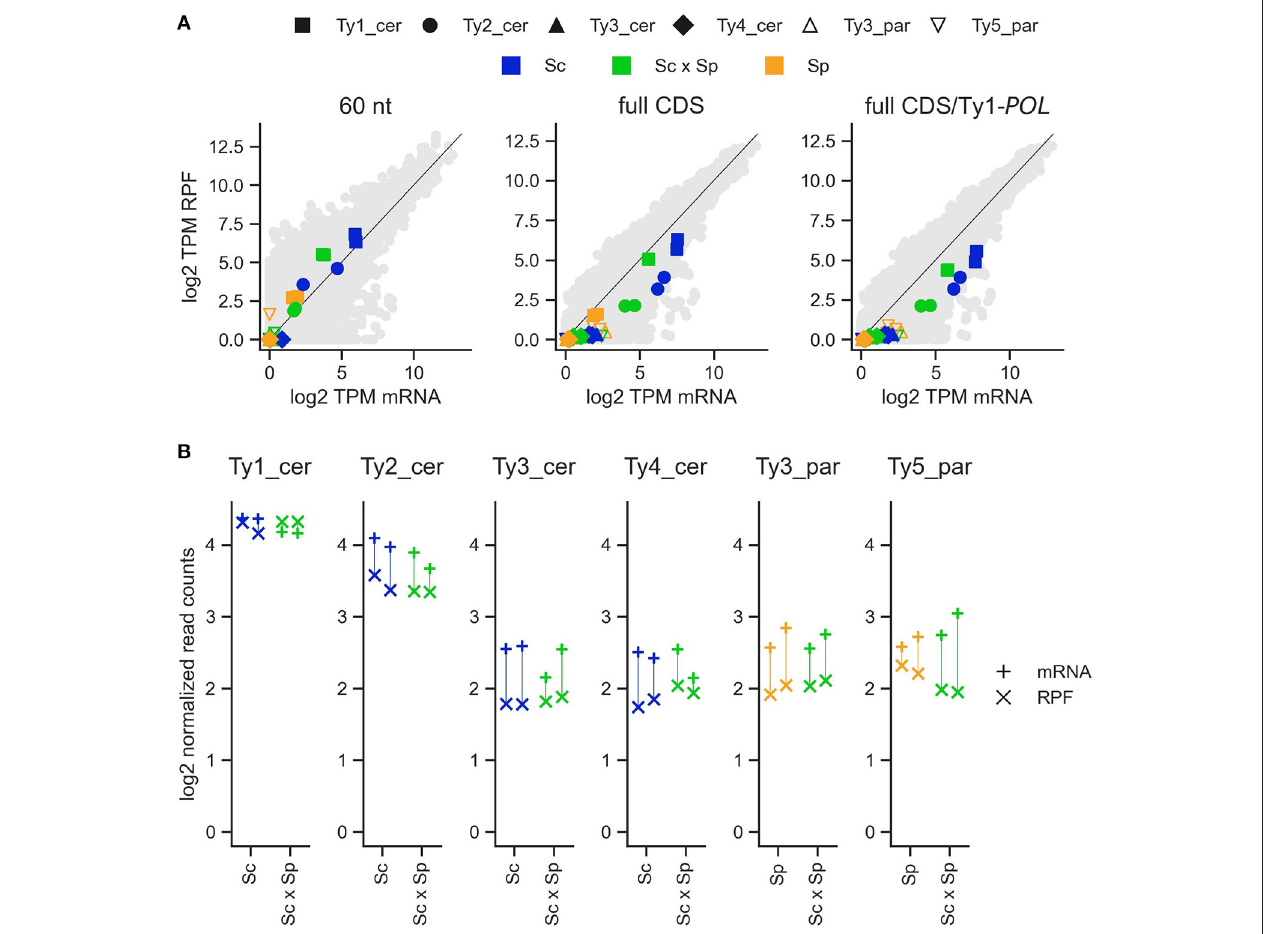
FIGURE 5 | Translation efficiency of Ty families in S. cerevisiae × S. paradoxus hybrids and their parents. (A) Expression level per Ty family for matched replicates of total mRNA and ribosome profiling (RPF) RNA-seq experiments. Host genes are shown as background grey dots. Left: Transcripts Per Million (TPM) for the first 60 nucleotides of each CDS. Center: TPM for the entire length of each CDS. Right: TPM for the entire length of each CDS, but with Ty1_cer in both species truncated to the POL -specific region only. (B) Normalized read counts for total mRNA and RPF libraries for each Ty family. Matching replicates are joined by vertical